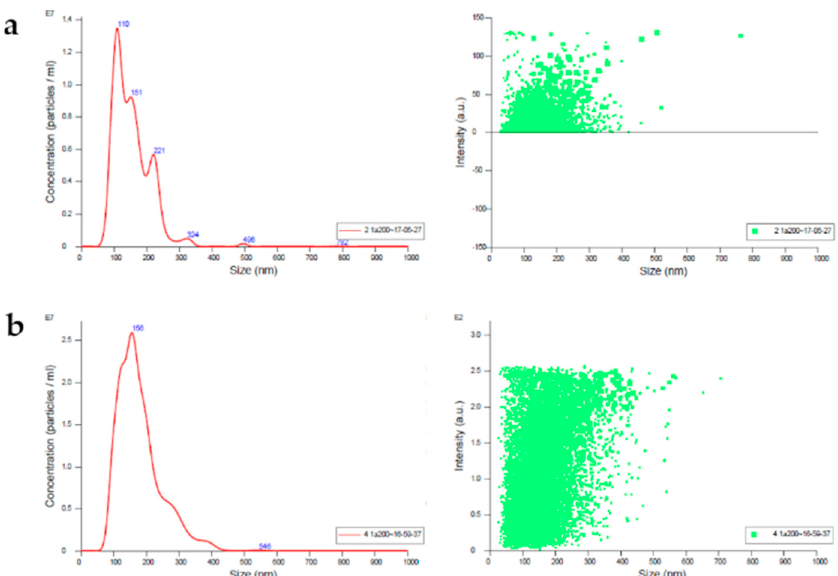
Figure 2. Quantification and size distribution of isoelectric precipitated and isolated milk exosomes, recorded through Nanosight (Malvern Panalytical, Malvern, UK) under light scatter mode. Red line indicates the signals recorded and depicts the extracellular vesicles (EVs) distribution in the sample, and the green spots indicate the intensity of the signals in an arbitrary unit (a.u.). ( a ) The sample has a concentration of 3.32 × 10 9 particles/mL and denotes different EVs population, with peaks at 110, 151, 221, 324, 496 and 782 nm. The mean size is 178.4 nm and the mode is 155.4 nm; ( b ) The sample has a concentration of 1.34 × 10 9 particles/mL and denotes only an EVs population with a peak at 156 nm, and with an irrelevant peak at 546 nm. The mean size is 154.2 nm and the mode is 109.3 nm.